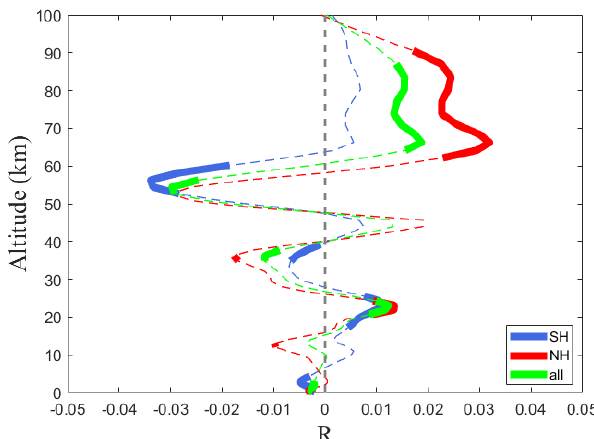
Figure 6. The linear regression coefficient of normalized Niño3.4 in δR (the anomaly of the ratio of the absolute to planetary vortic- ity). The thin dashed red, blue, and green lines denote the averages of the Northern Hemisphere (from 15 to 30 ◦ N), Southern Hemi- sphere (from 15 to 30 ◦ S), and the whole (15–30 ◦ N and 15–30 ◦ S), respectively. The thick, solid lines denote confidence levels higher than 95% for the F test.